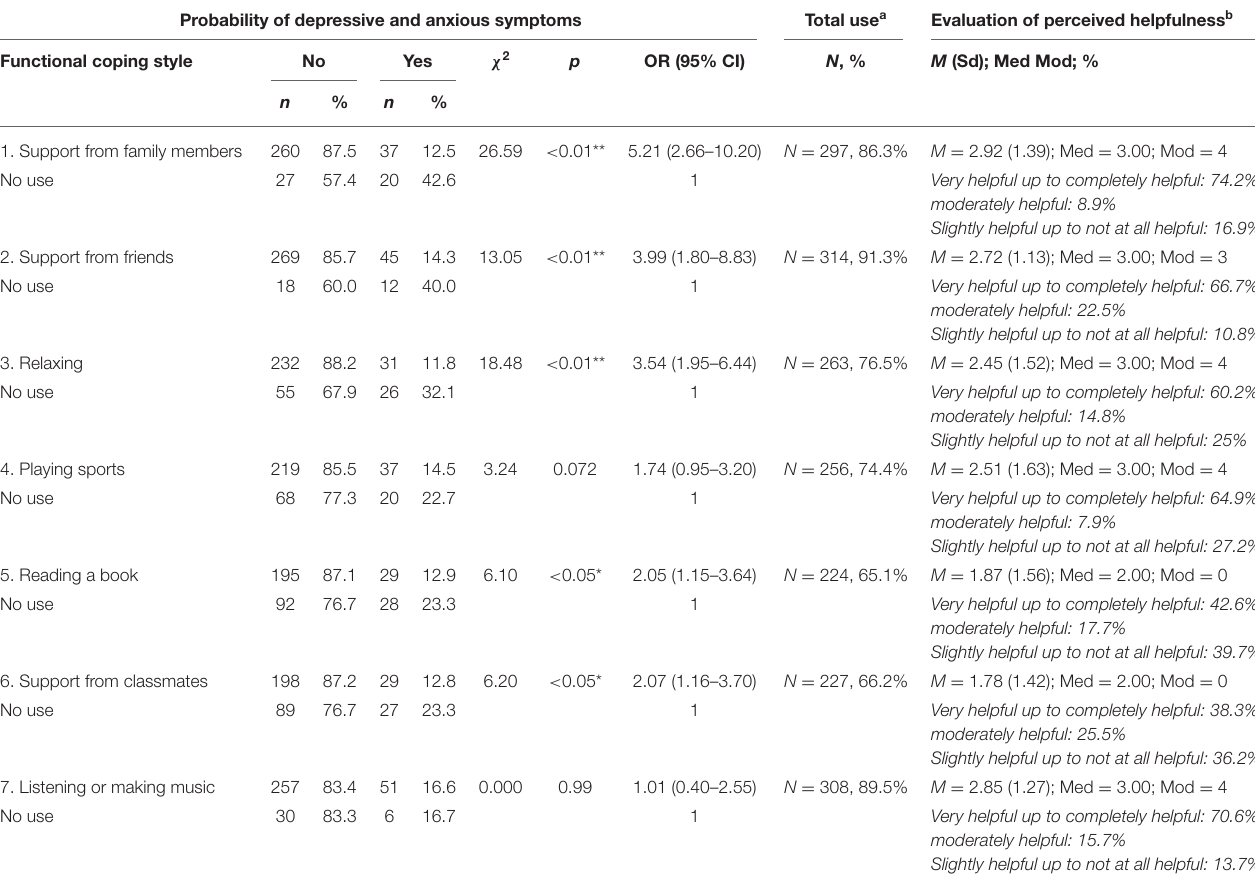
TABLE 6a | Reporting on identified functional coping strategies with associated OR, frequencies of use, and subjective assessment of the usefulness of the strategy. Probability of depressive and anxious symptoms Total use